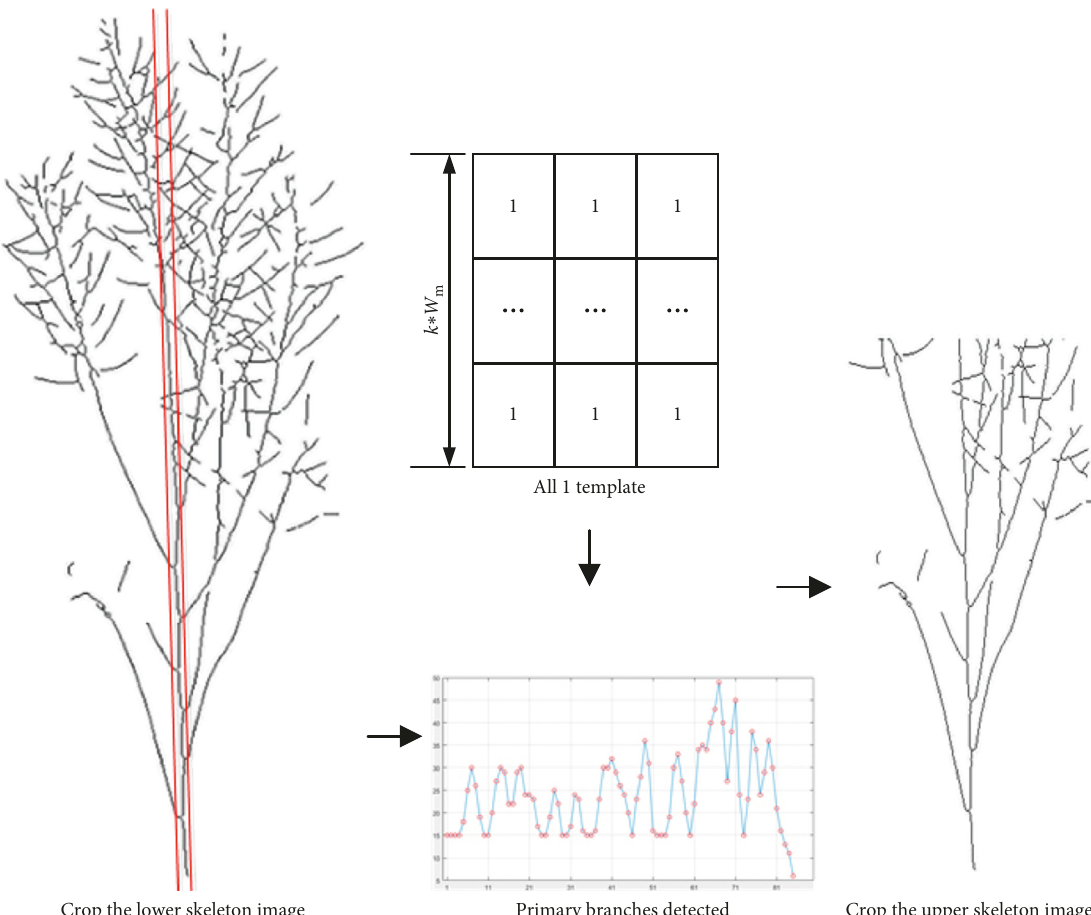
Figure 5: Image of automatic plant cropping.